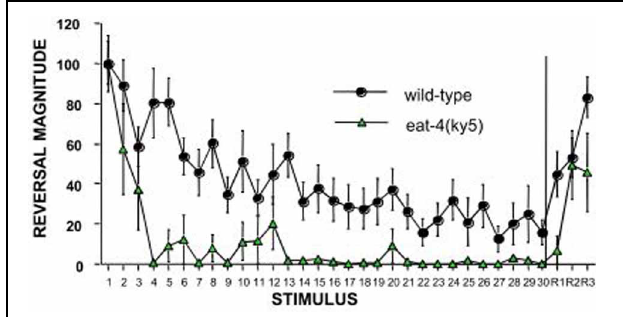
FIGURE 2 | An example of the candidate gene approach: eat-4 encodes a glutamate vesicle transporter and is expressed on the touch cells. Worms with a mutation in eat-4 show rapid and complete habituation and slower recovery compared to wild-type worms (Rankin and Wicks,